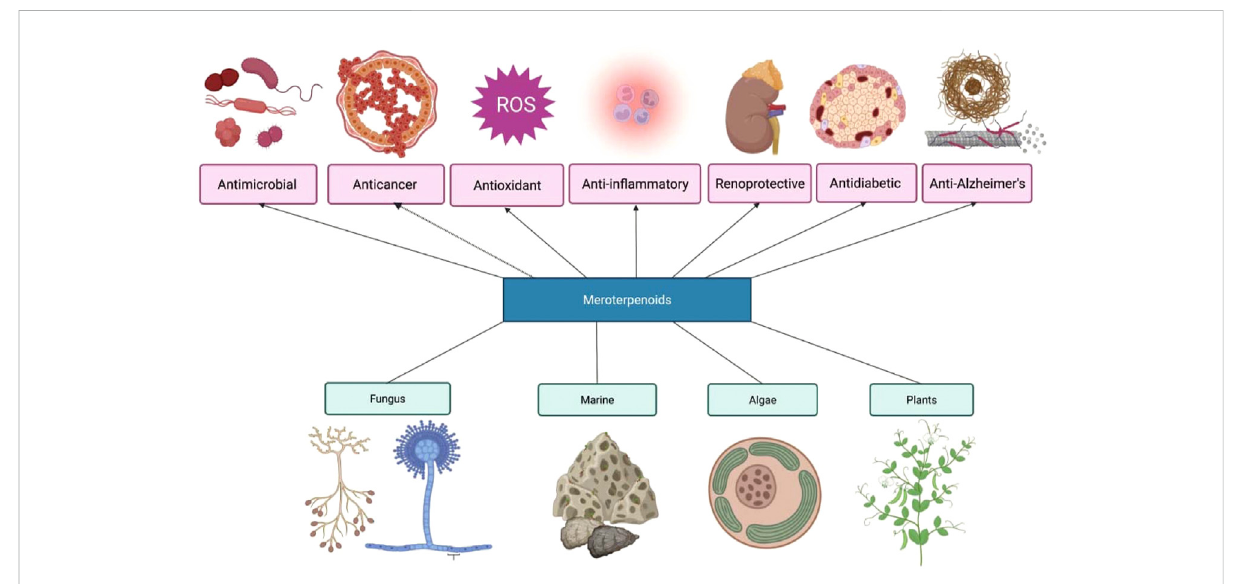
FIGURE 5 Biological activities of meroterpenoids obtained from various